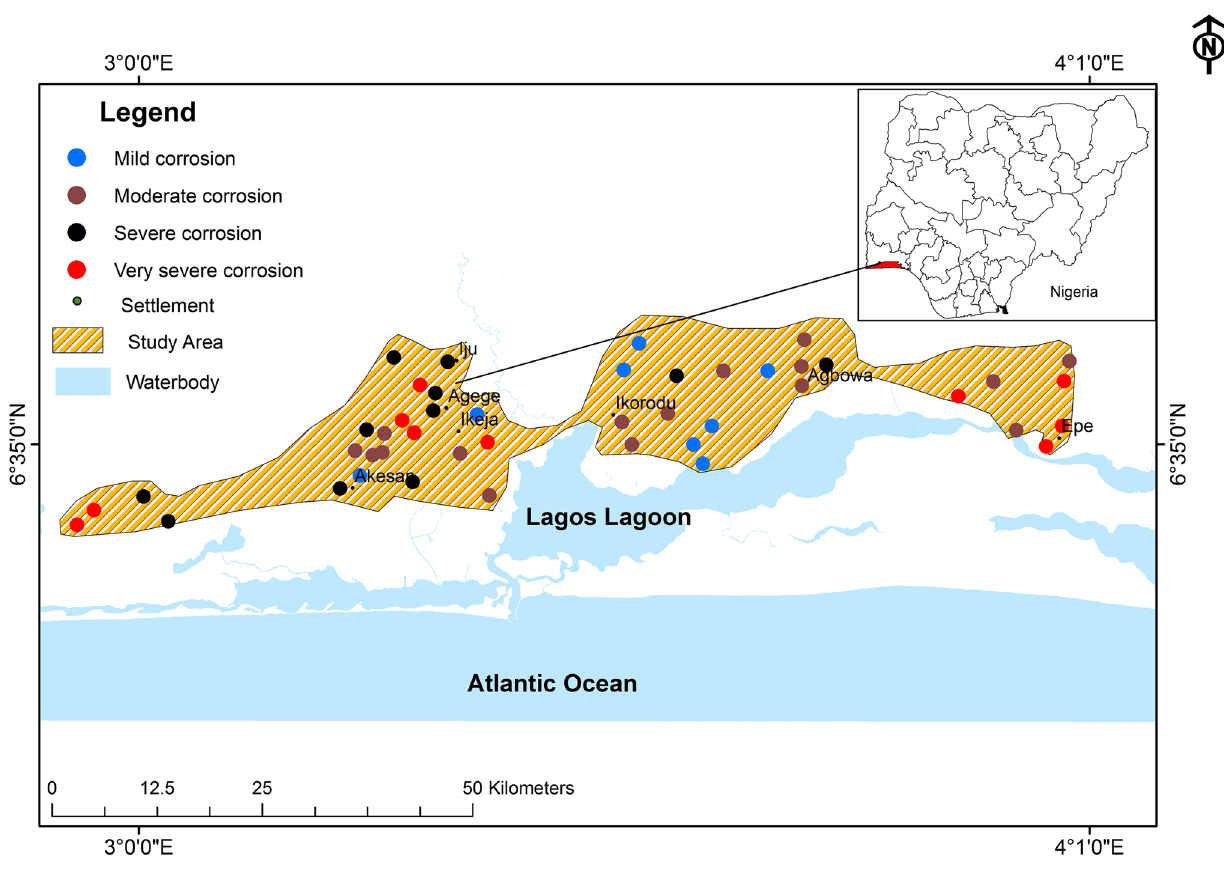
Fig. 9 Distribution of Langelier index in the wet season Table 7 Characterization of groundwater of the study area on Piper’s plot